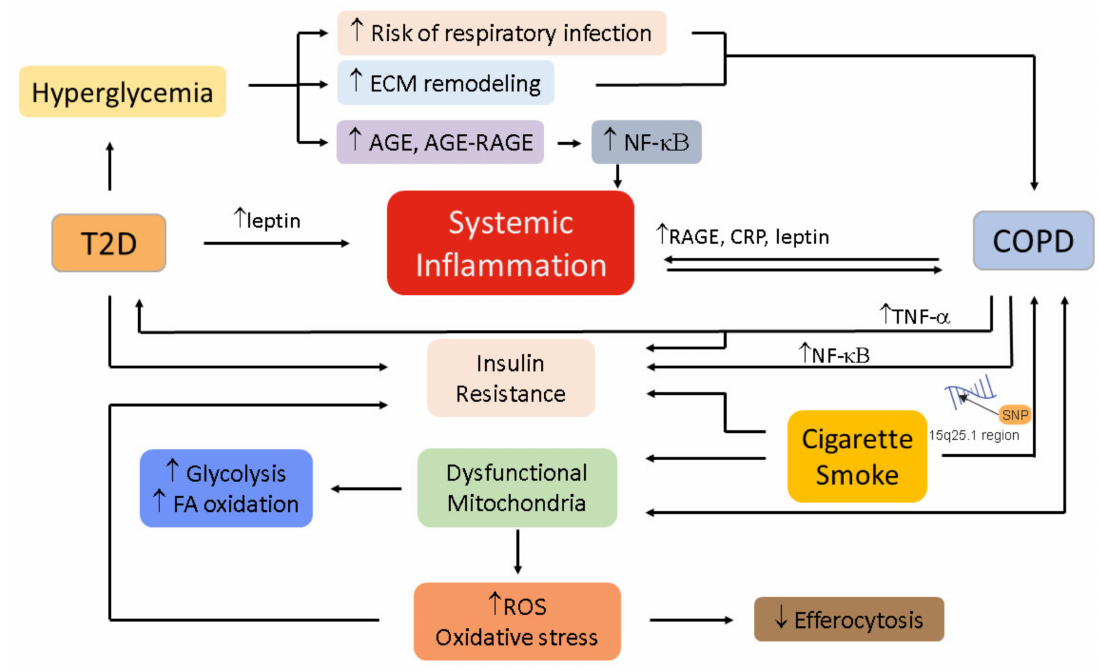
Figure 2. Possible mechanisms linking T2D to